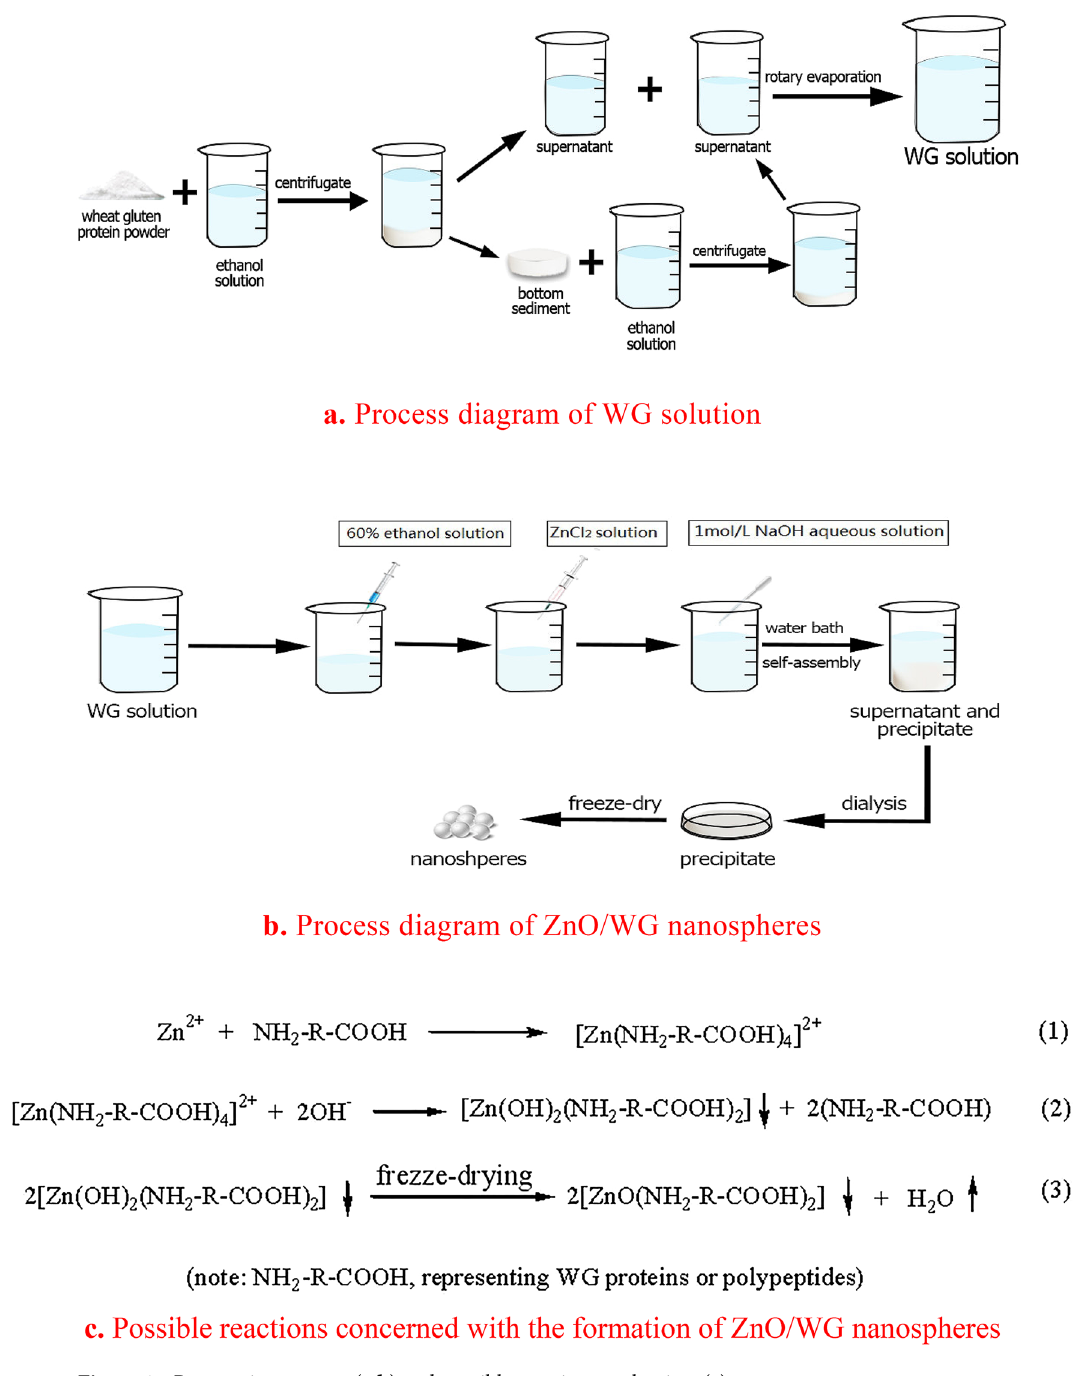
Figure 1. Preparation process ( a , b ) and possible reaction mechanism ( c